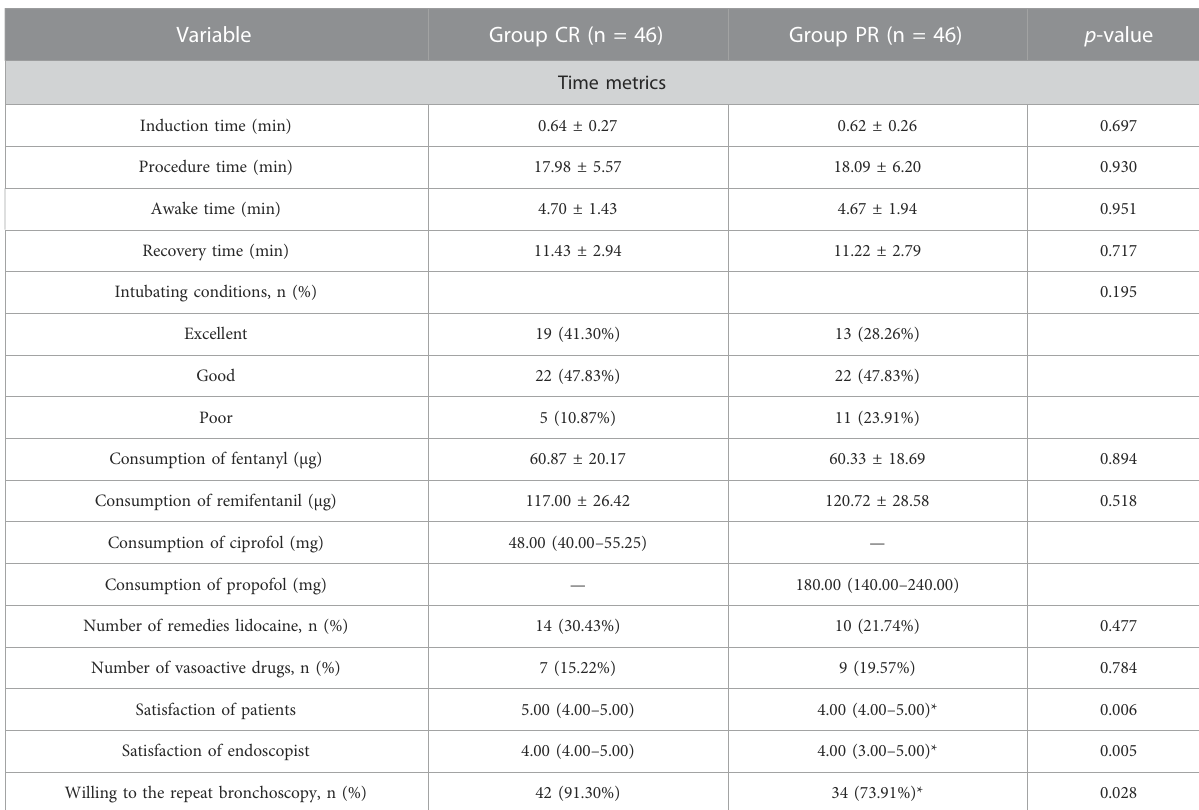
TABLE 3 The secondary outcomes in this